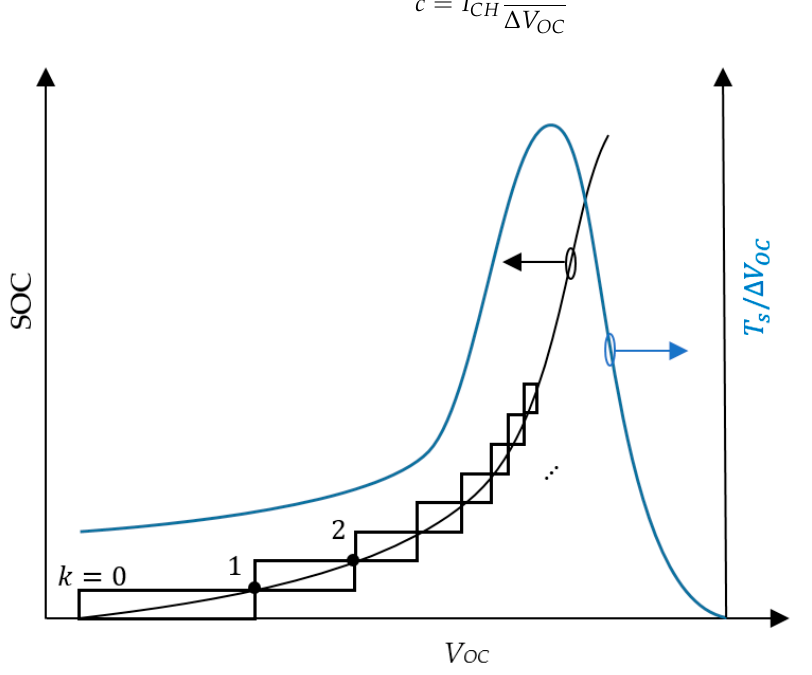
Figure 9. The reciprocal of charging voltage slew rate in constant current